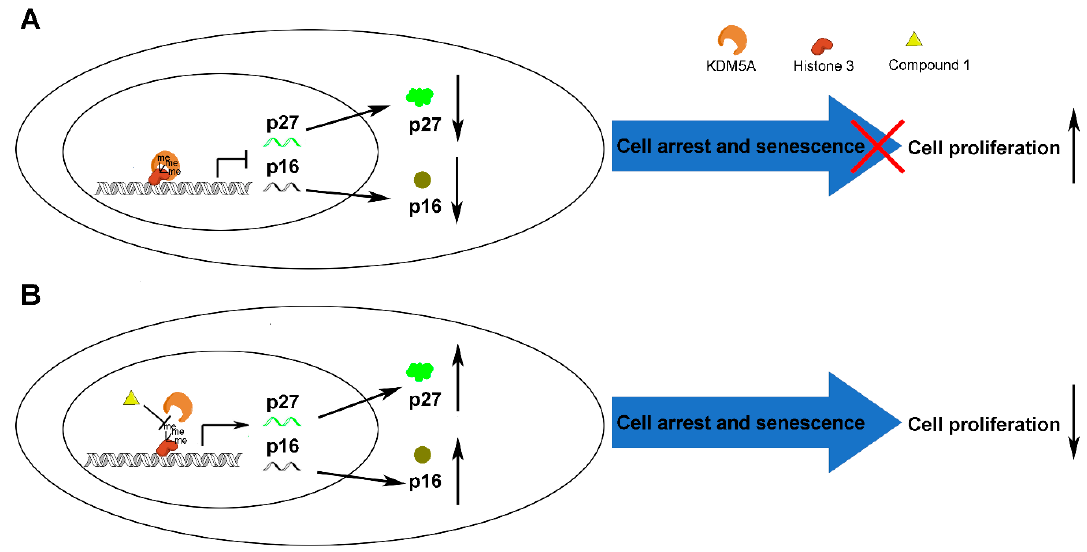
Figure 7. Proposed mechanism of how compound 1 induces anticancer effects in breast cancer cells. Compound prevents H3K4me3 and H3K4me2 from binding to KDM5A, resulting in the upregulation of H3K4me3-mediated gene transcription.